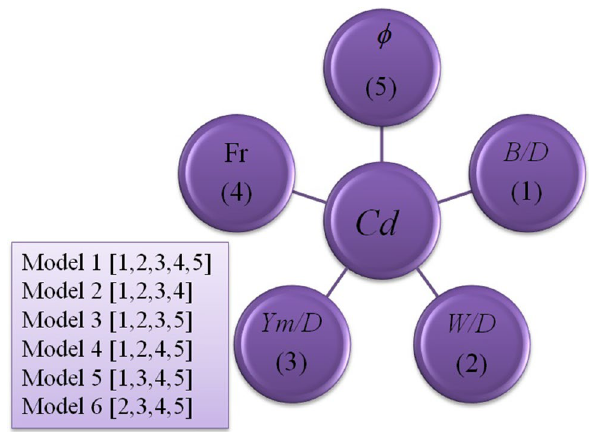
Fig. 4 Combinations of different artificial intelligence models